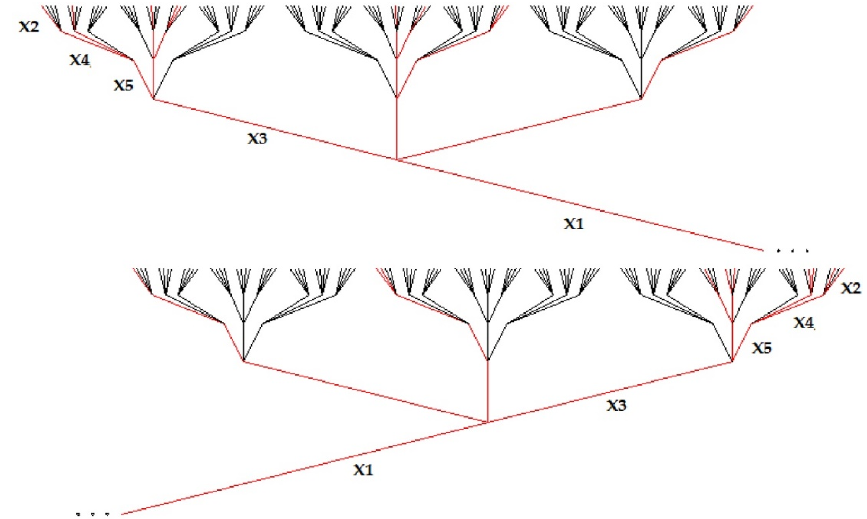
Figure 5. Optimal multi ‐ valued decision tree with a floor layout of X 1 , X 3 , X 5 , X 4 , X 2 .